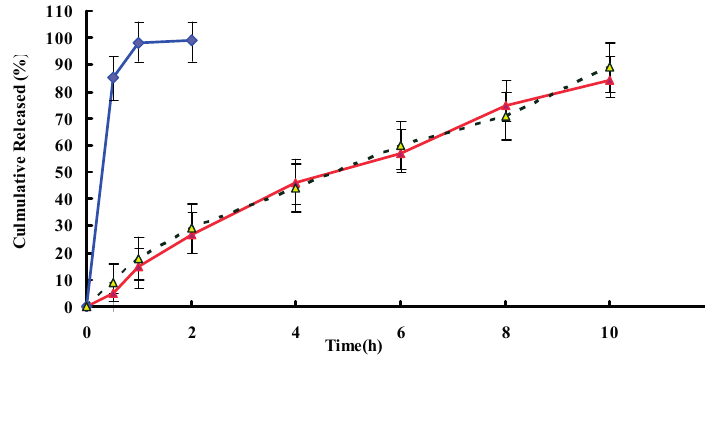
Figure 2. Drug release profiles of PPF pellets (red), tablets (blue) and stability samples (yellow and dotted line) in 0.1 N hydrochloric acid solution (pH 1.2) for 2 h and followed by addition of PBS solution (pH 6.8) for remaining time ( n = 6).